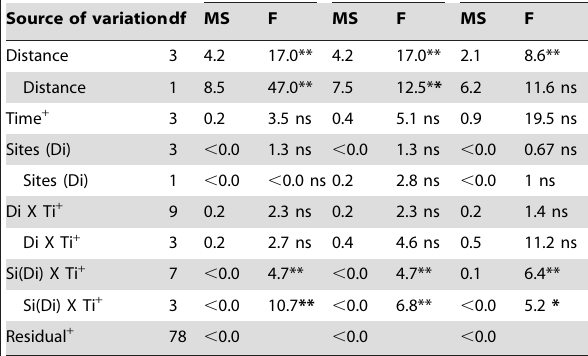
Figure 3. Number ( ± SE; n =4 at the Effluent and and 8 at the other sites) of taxa found in each time at the Effluent site (squares), the sites 600 m (triangles) and 1400 m away from the effluent (inverted triangles) and at the control sites (circles). Note that in times T3 and T4, only one control (C2) was sampled due to losses of replicates.